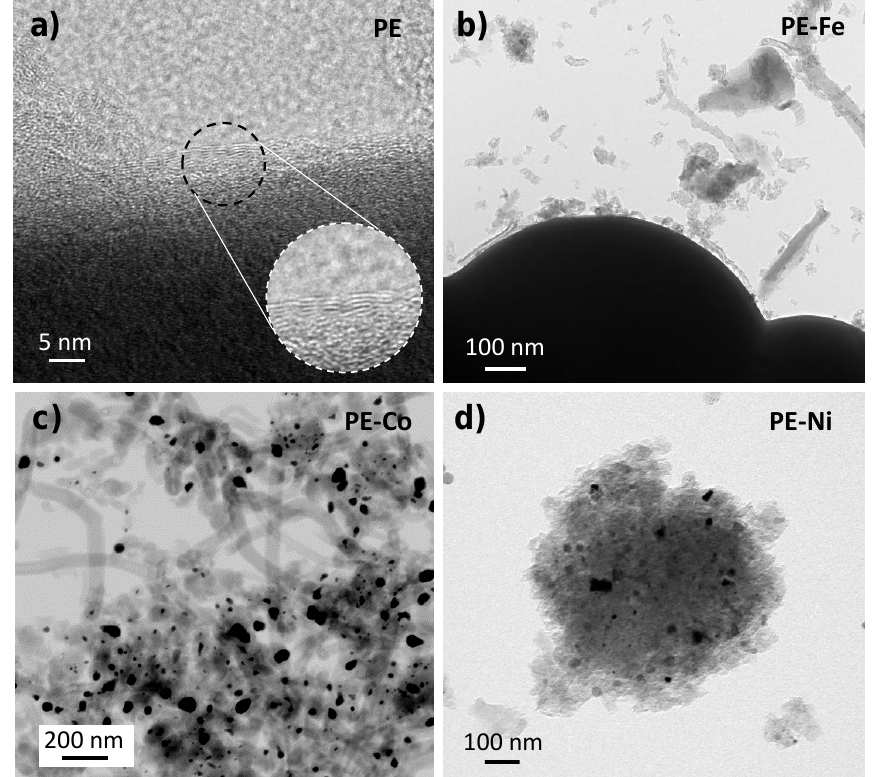
Figure 3. ( a – d ) TEM and HRTEM images.